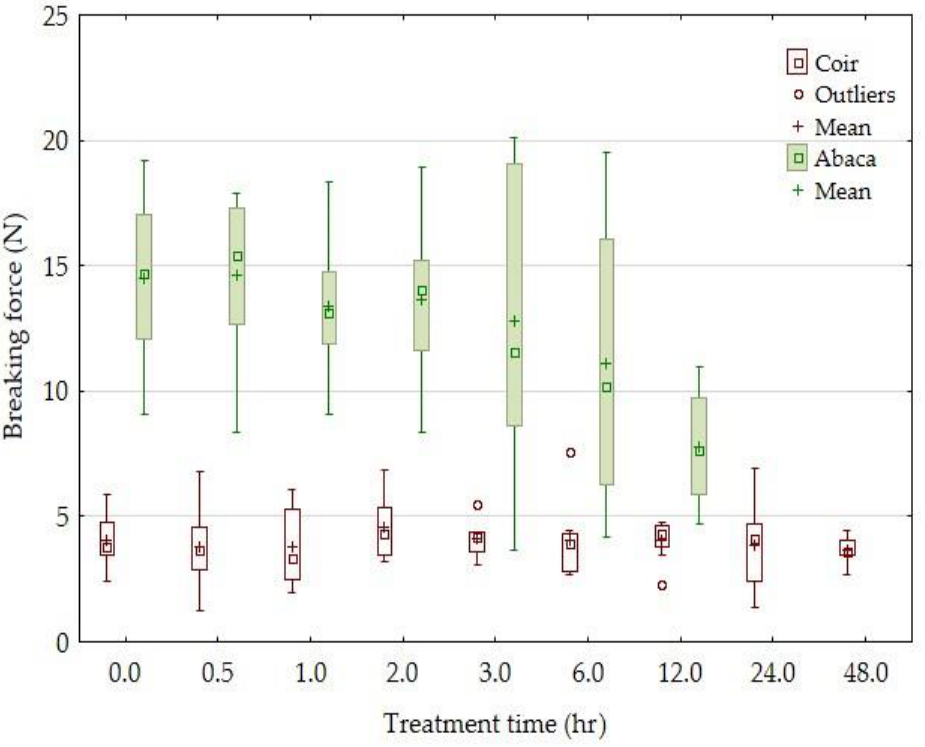
Figure 3. The dependence of the breaking force of the coir and abaca fibers on the time of treatment in a 5% solution of NaOH.